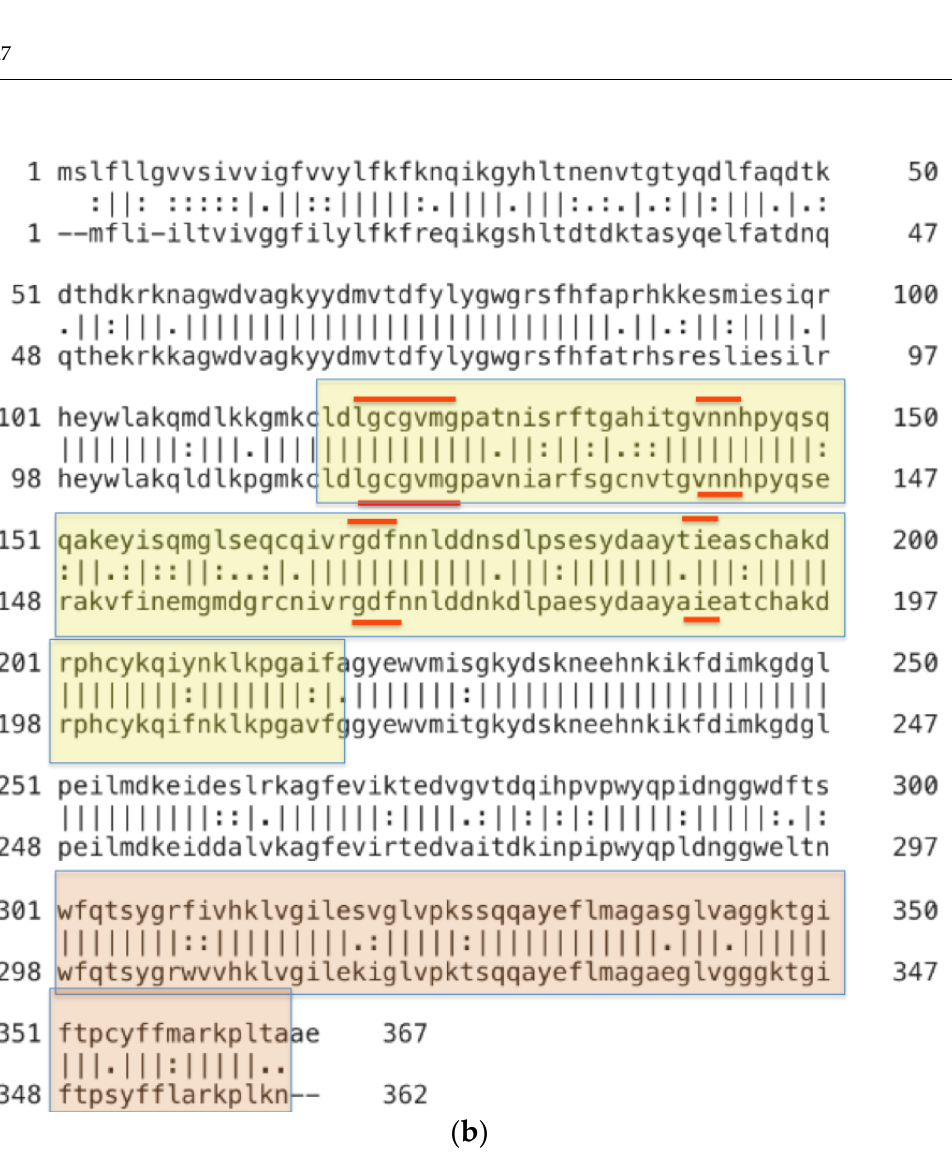
Figure 1. Sequence comparison of SMT: ( a ) Comparison between yeast derived ERG6, N. gruberi derived XM, and XP. ( b ) Comparison between N. gruberi derived XM and XP. Light yellow box denotes the SAM domain while the light orange box denotes the sterol methyltransferase C-terminal domain. The red lines denote the amino acid residues that are predicted to bind S-Adenosylmethionine. Amino acid residues for SAM domain and the sterol methyltransferase C- terminal domain are highlighted in Figure 1b. Amino acid residues binding